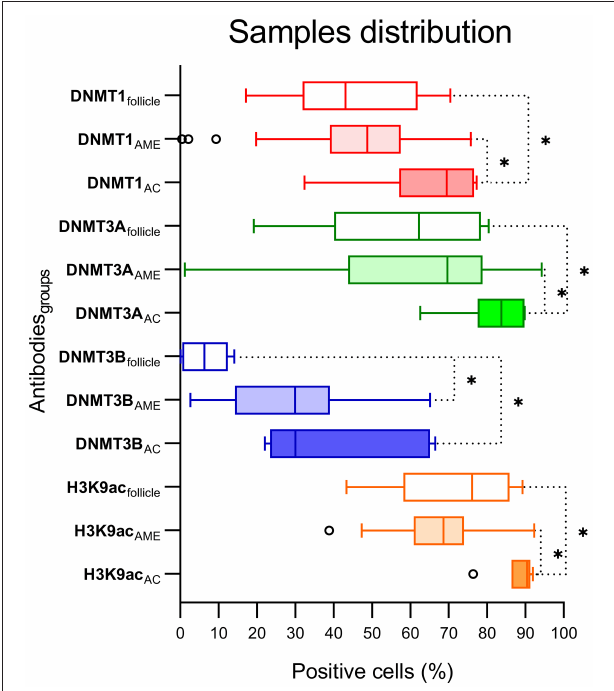
FIGURE 2 | Graphic distribution of positive cells (%) for each antibody and DF, AME, and AC groups. *Statistical difference between groups comparison.